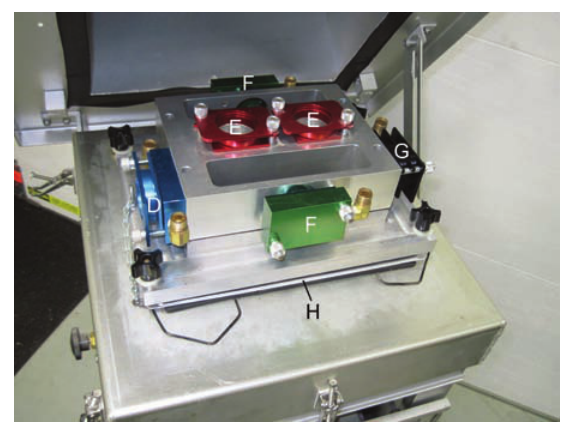
Fig. 9 Photo of 1.0 µm base showing 47 mm filter hold- er placements.